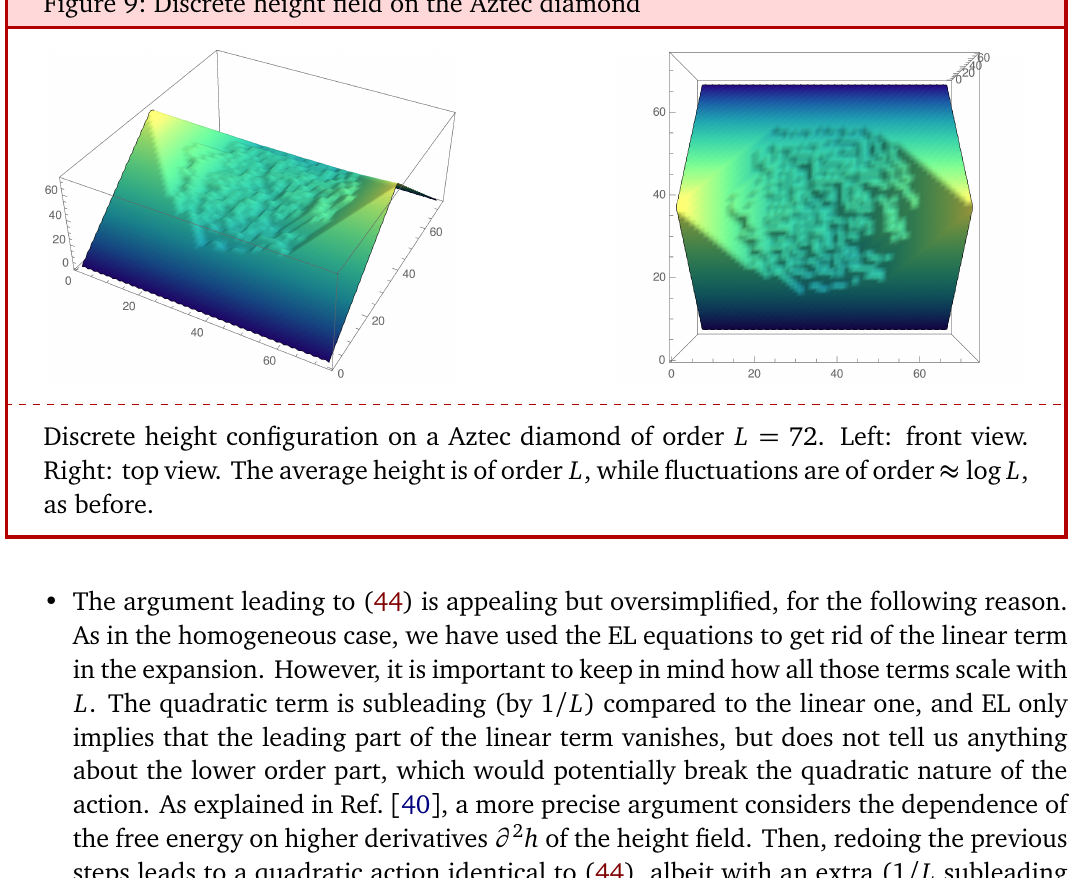
Figure 9: Discrete height field on the Aztec diamond